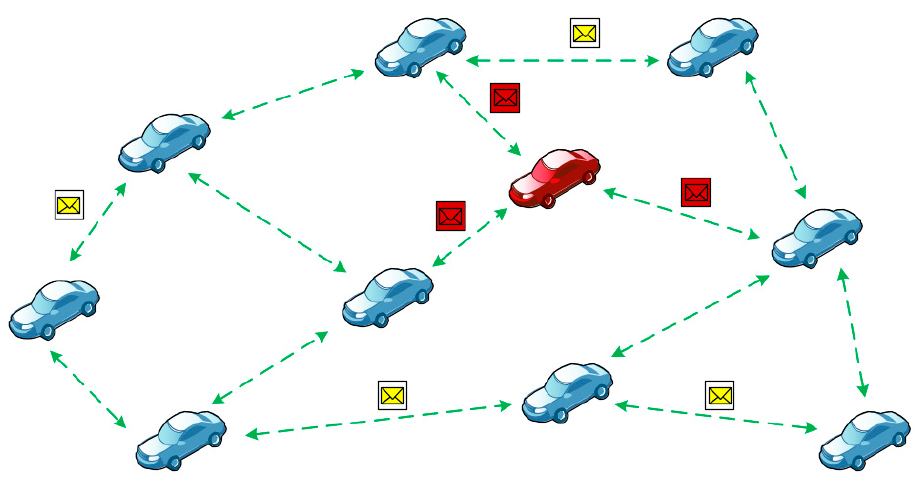
Figure 10. The illusion attack case.